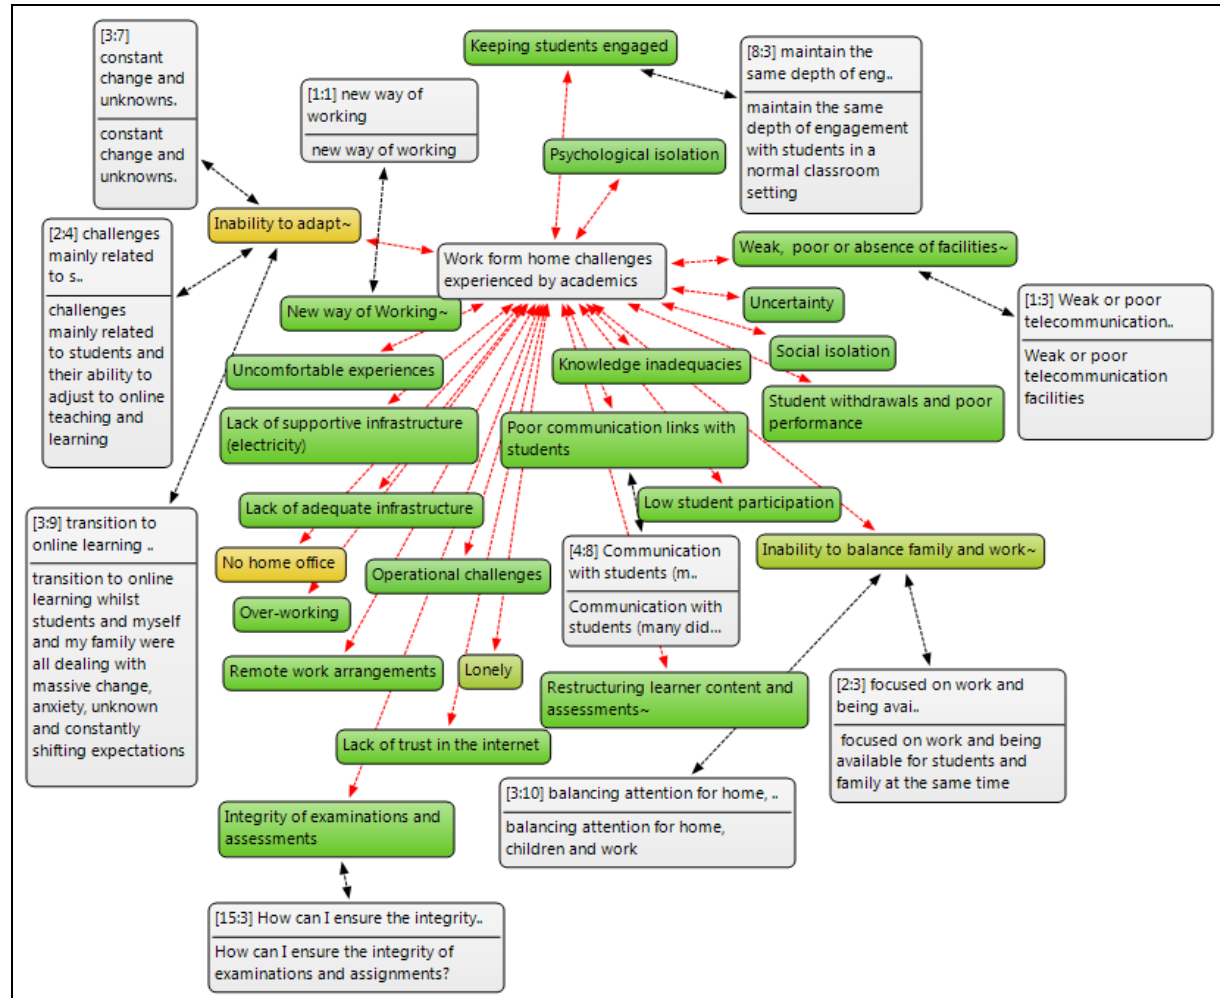
Figure 3. Challenges to virtualisation that were faced by